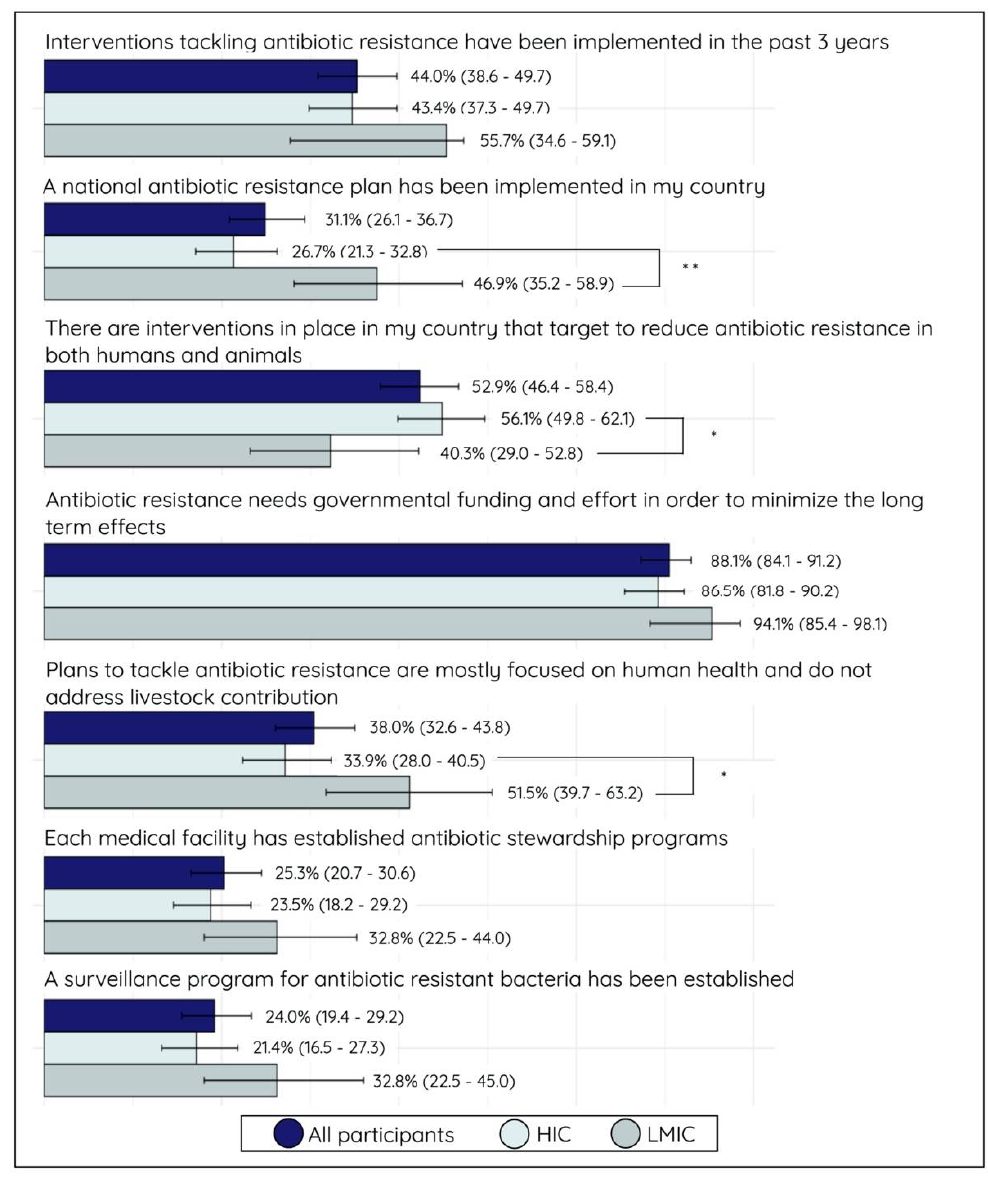
Figure 4. Bar plot (proportion (%) with 95% confidence interval) on the first part of statements assessing the political knowledge, attitudes, and perceptions (KAP) of all participants, stratified for high-income country (HIC) and low- and middle-income country (LMIC) participants. The proportion represents participants who answered the statement with agree or strongly agree. Significance: ** p < 0.01, and * p < 0.05.